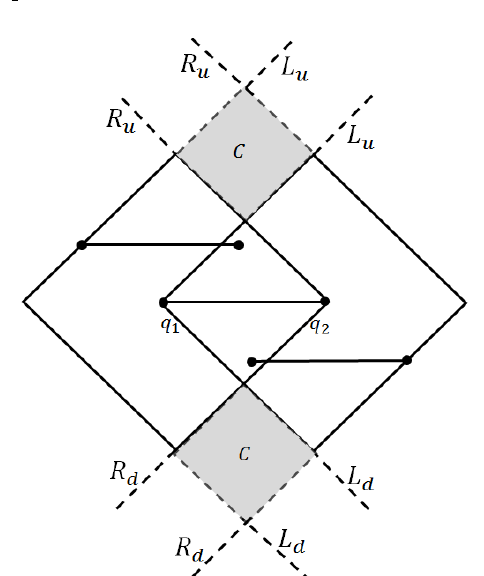
Figure 6. Definition of critical regions C by lines passing through edges of a